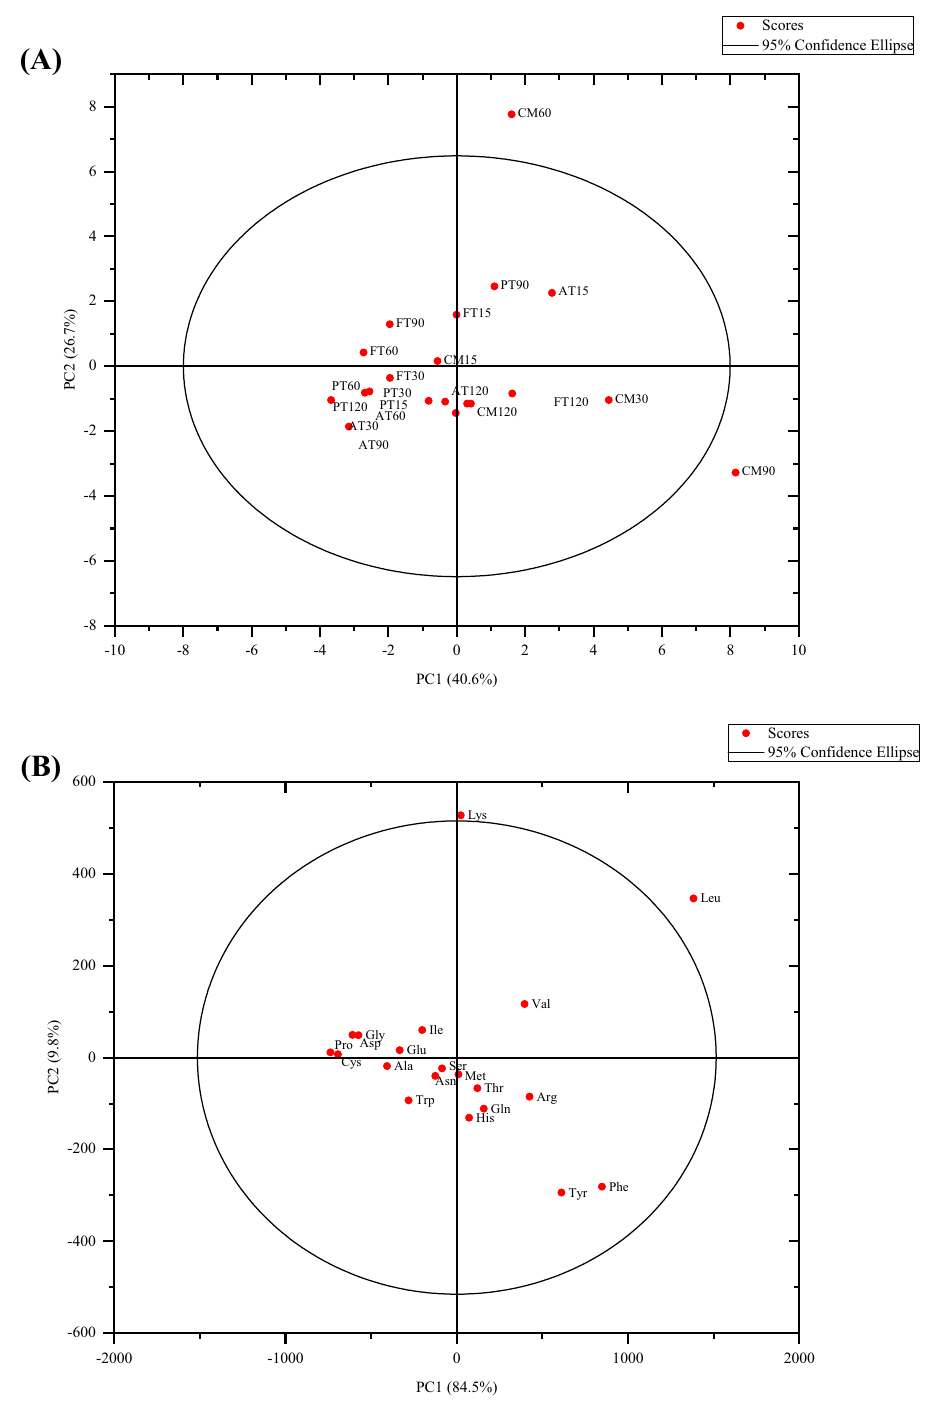
Figure 7. PCA score plot ( A ) and PCA correlation loadings plot ( B ) of the principal components of free amino acids from CM, AT, PT and FT. Alcalase-treated cow milk (AT), Protamex-treated cow milk (PT), Flavourzyme- treated cow milk (FT). Each dot represents identified and quantified free amino